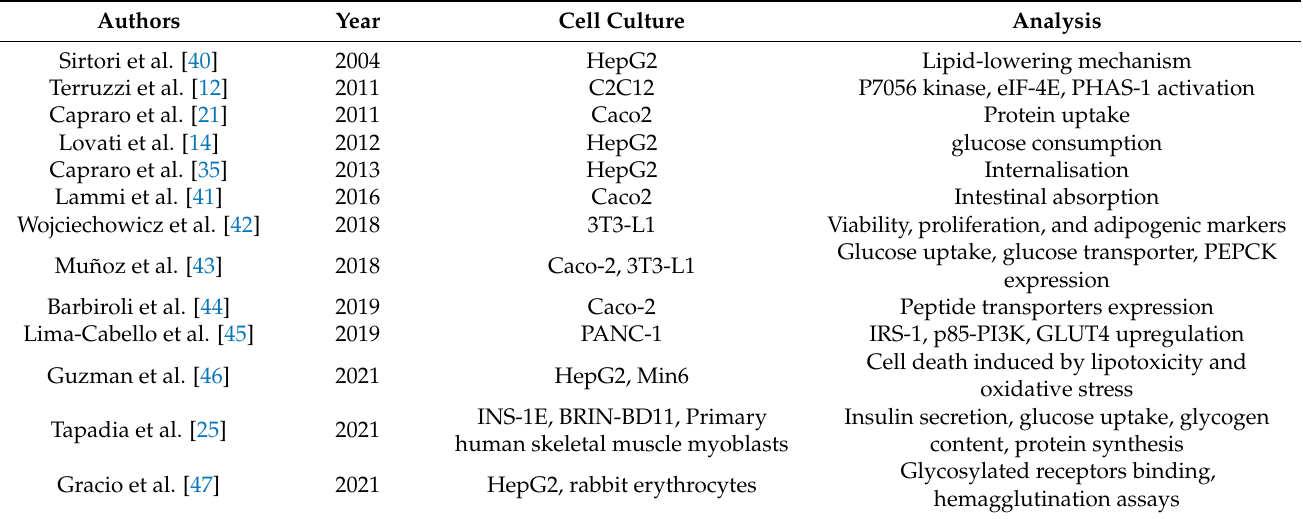
Table 3. Conglutin- γ in vitro studies on different cell